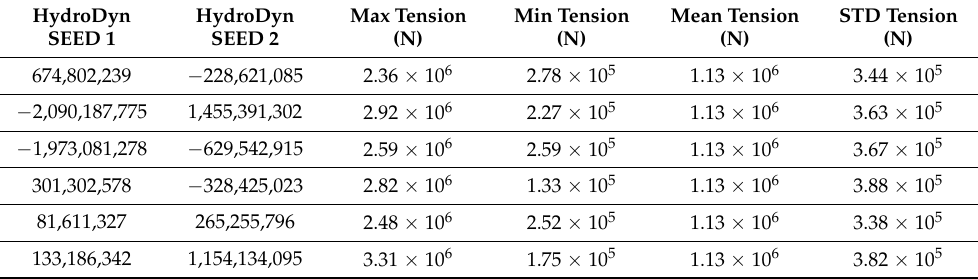
Table 6. DLC 6.1 Results for VolturnUS 6-MW Moored with a Basin Tested 6-MW System (0 Degree Loading; Front